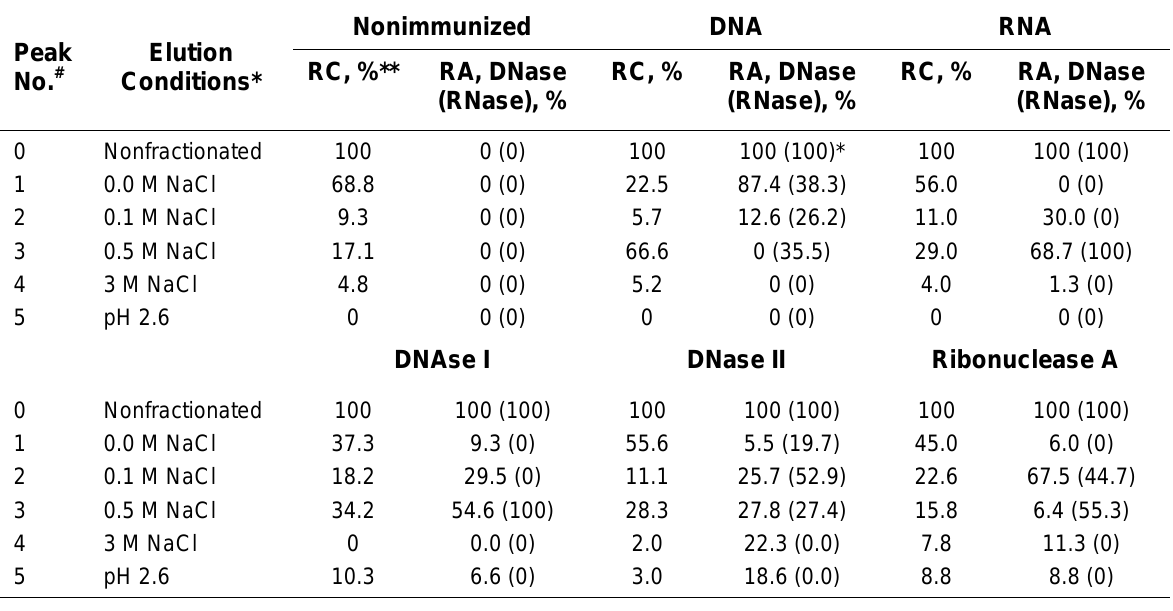
Electrophoretically homogeneous IgGs from healthy rabbits and animals immunized with DNA, RNA, DNase I, DNase II, and pancreatic RNase A were loaded onto a DNA-cellulose and proteins were eluted with Tris-HCl buffer, pH 7.5, containing different concentrations of NaCl (0.1 – 3 M) and then with 50 mM glycine-HCl, pH 2.6. Five IgG fractions were collected, dialyzed, and each fraction was used in the DNase and RNase activity assay. ** RC and RA are relative content of IgGs and relative activity of Abs in the case of every peak. # Peak numbers are the same for all five